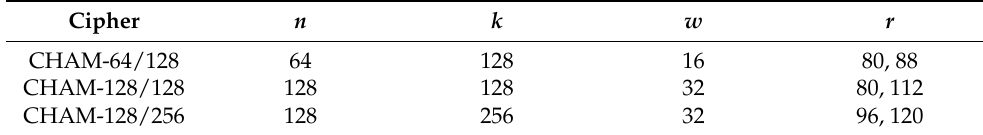
Table 1. CHAM’s parameters.